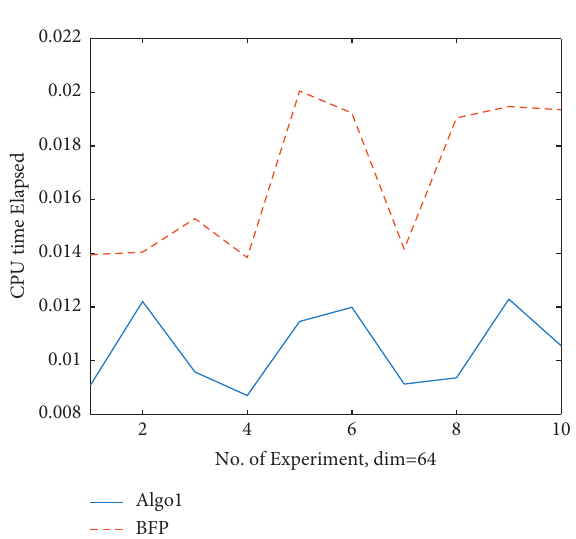
Figure 23: CPU time vs no. of iteration for dimension